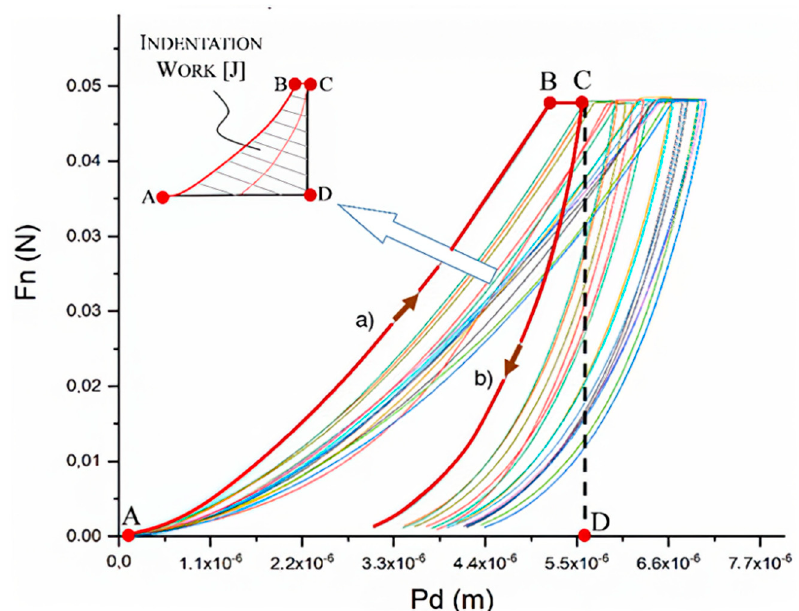
Figure 9. Fn vs. Pd curves for a CFPP bare laminate; ( a ) loading part of the curve, ( b ) unloading part of the curve. The insert highlights the indentation work. Sixteen curves are reported for each indentation point.